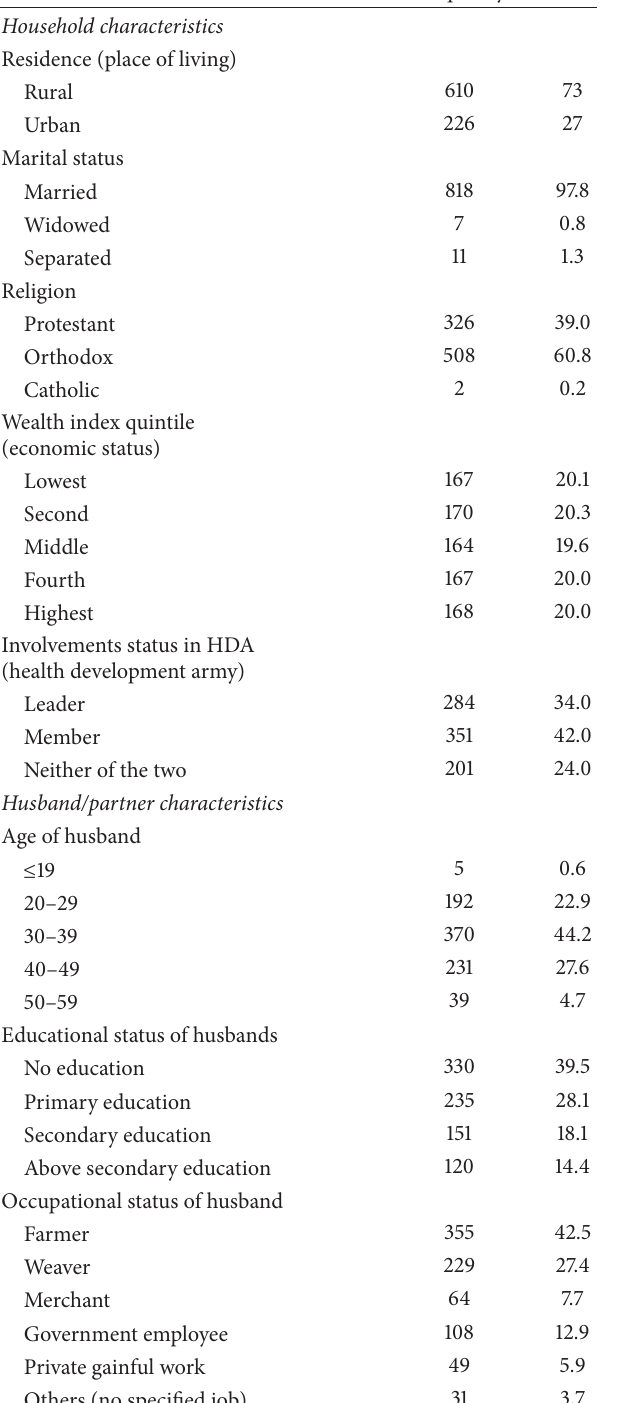
Figure 1: Men’s awareness of danger signs of obstetric complications at Chencha district, southern Ethiopia, 2014.